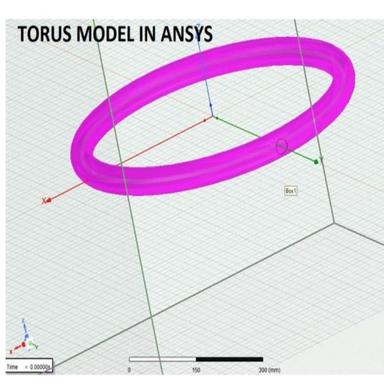
ANSYS Model of torus.